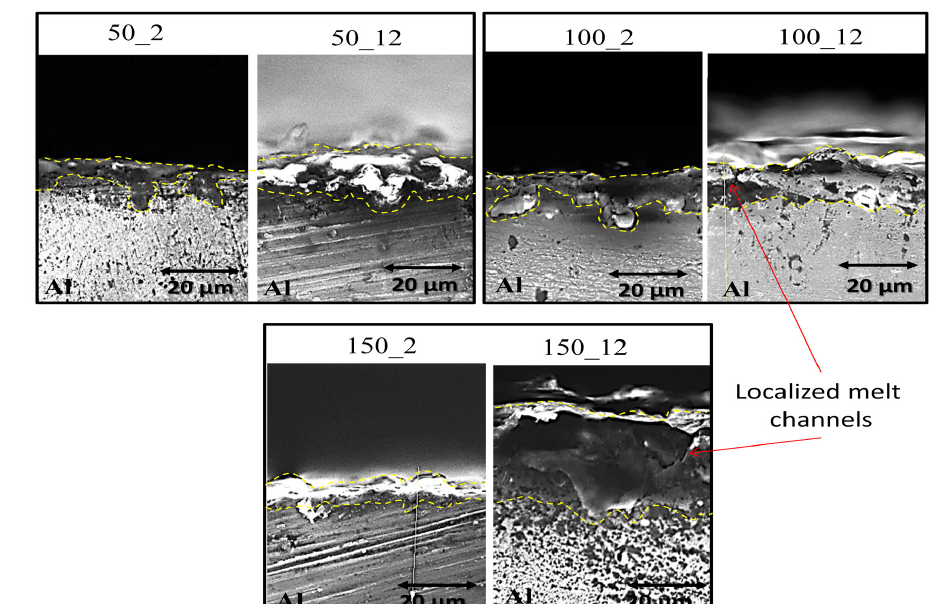
Figure 7. SEM micrographs of the cross-sections of the PEO coatings prepared under different